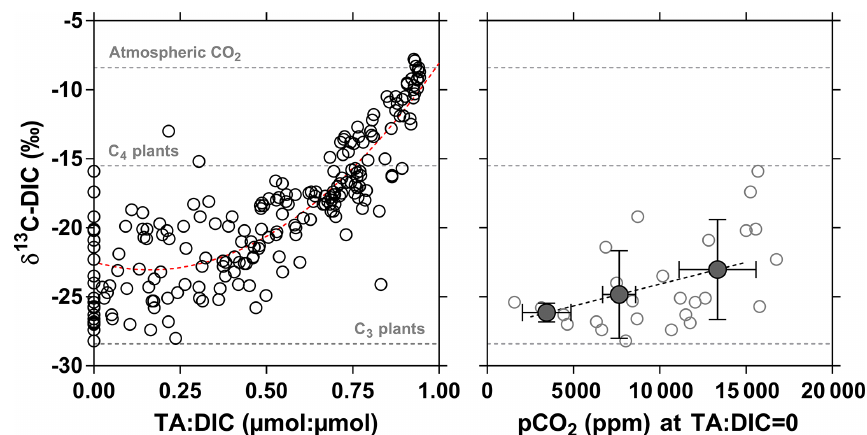
Figure 17. Carbon stable isotope composition of dissolved inorganic carbon (DIC) ( δ 13 C-DIC in ‰) as a function of the total alkalinity (TA) to DIC ratio (µmol:µmol) and as a function of the partial pressure of CO 2 ( p CO 2 in ppm) for a TA:DIC ratio equal to zero in surface waters of rivers and streams of the Congo River network. Open dots indicate individual data points, full dots indicate binned averages ( ± stand deviation) (bins <5000, 5000–10000 and >10000ppm). Horizontal dotted lines indicate the δ 13 C values of atmospheric CO 2 and of average soil organic carbon stable isotope composition with a dominance of C 4 ( − 15 . 5 ± 0 . 8‰) and C 3 plants ( − 28 . 4 ± 0 . 7‰) (Bird and Pousai, 1997). Dotted red line provides polynomial fit ( δ 13 C-DIC =− 22 . 5 + 21 . 37 × TA:DIC − 6 . 97 × (TA:DIC) 2 , r 2 = 0 . 76).